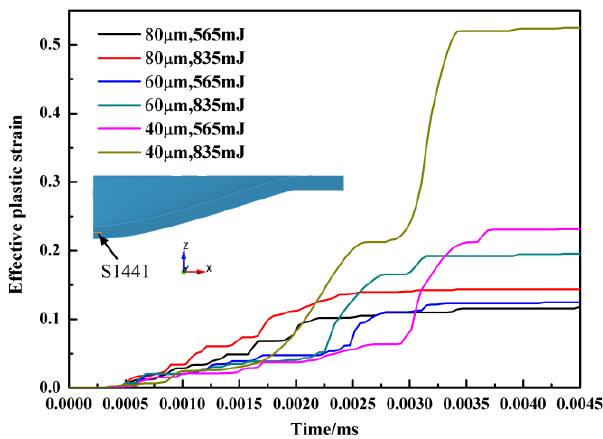
Figure 18. The variation of the equivalent plastic strain of element S1441.